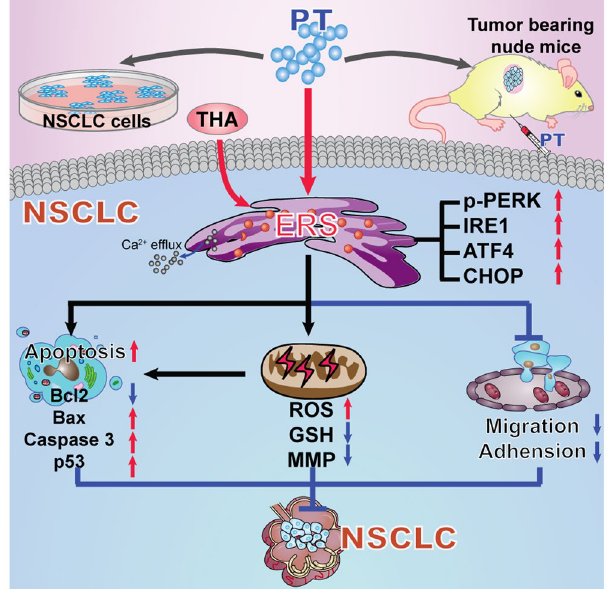
Figure 9. Schematic diagram about the anti-NSCLC activity of PT via the stimulation of ERS. Our in vivo and in vitro studies showed that PT treatment could stimulate ERS and upregulate a series of ERS-related molecules (i.e., p-PERK, IRE1, ATF4, CHOP) and promoting the efflux of Ca 2 + from ER into cytoplasm, thus promoting apoptosis (mechanisms via upregulation of Bax, Caspase 3 and p53 expression, and decrease of Bcl2 level), enhancing ROS generation and MMP depolarization, reducing intracellular GSH levels, and inhibiting the ability of migration and adhesion in NSCLC cells. Moreover, THA treatment can enhance the anticancer activity of PT on NSCLC. PT, pterostilbene; THA, thapsigargin; ERS, endoplasmic reticulum stress; NSCLC, non-small-cell lung cancer; p-PERK, phosphorylated-PKR-like ER kinase; IRE1, inositol-requiring enzyme 1; ATF4, activating transcription factor 4; CHOP, C/EBP-homologous protein; Bcl2, B-cell lymphoma-2; Bax, Bcl2-associated X protein; ROS, reactive oxygen species; GSH, glutathione; MMP, mitochondrial membrane